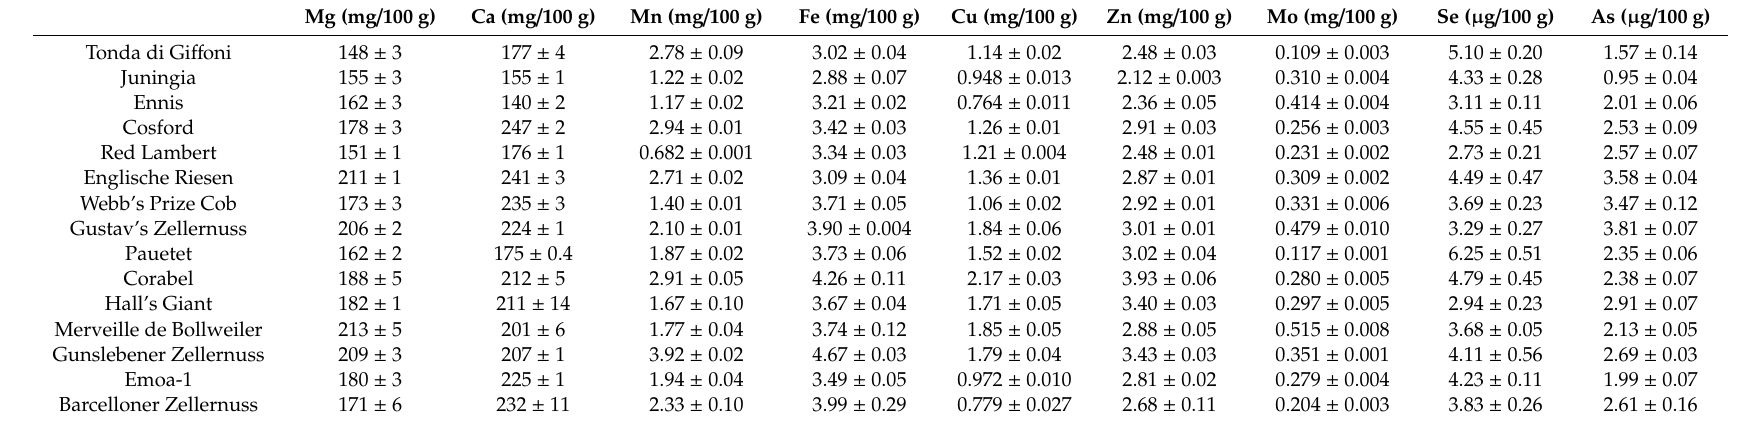
Data refer to fresh weight; values are expressed as means ± SD ( n =